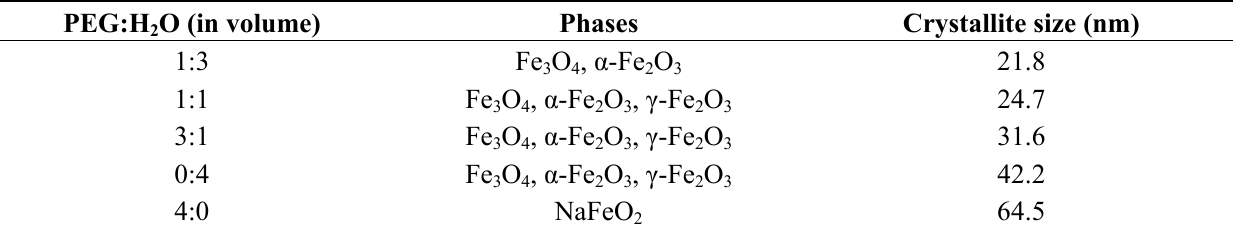
Table 1. Influence of the PEG:H O volume ratio on the identified phases and crystallite 2 size collected from X-ray diffraction (XRD) data. All samples are prepared at 150 °C for 24 h. Reprinted with permission from [19]. Copyright 2008 Elsevier B.V.